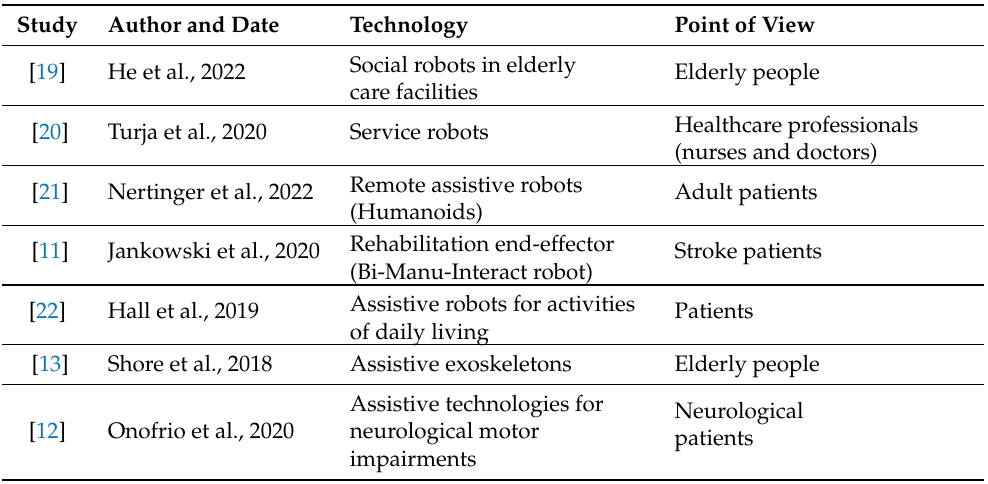
Table 1. Summary of relevant works from the literature investigating applications of the TAM for robotics in healthcare. Types of technologies and interviewed users are indicated in the last two